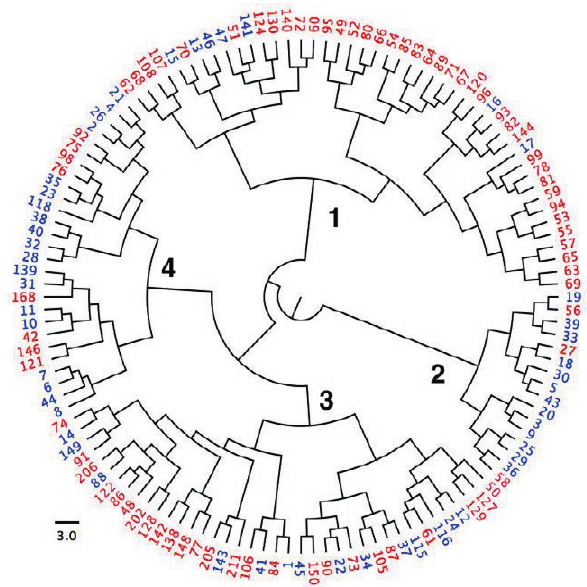
Figure 1. Ward dendrogram of rice genotypes based on SSR